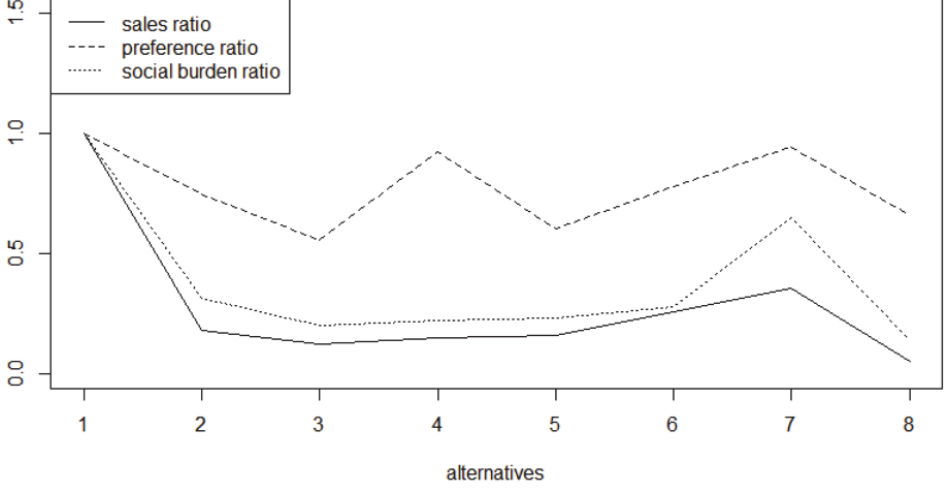
<Figure 4> Sales ratio, preference ratio and social burden ratio (reference good: alternative